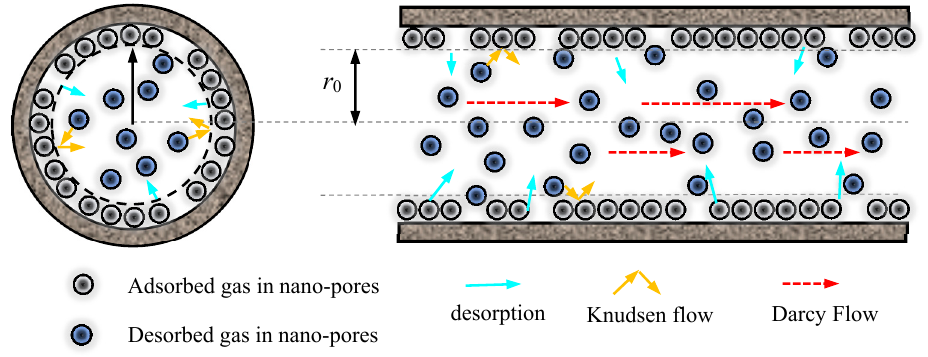
Figure 1. The flow in nan-pores of shale reservoirs.